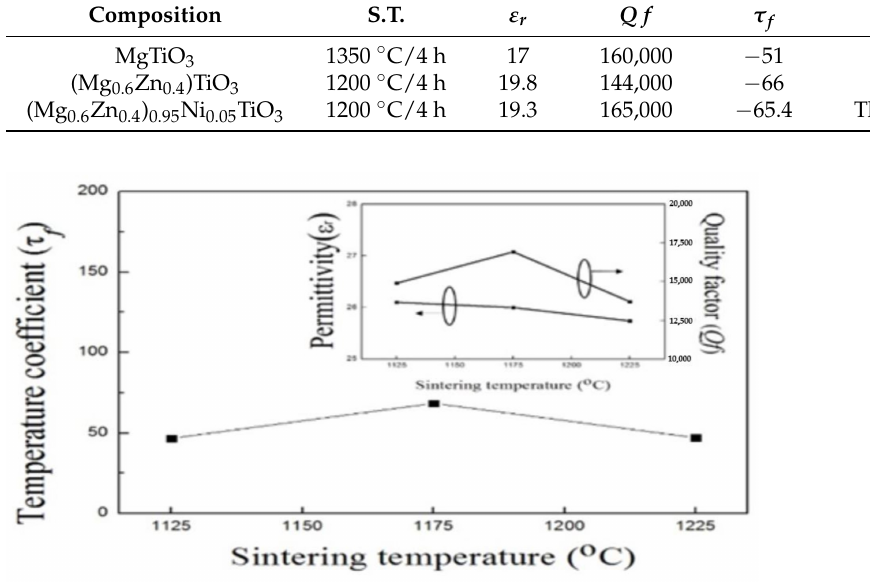
Figure 8. Microwave performance of 0.94(Mg 0.6 Zn 0.4 ) 0.95 Ni 0.05 TiO 3 − 0.06SrTiO 3